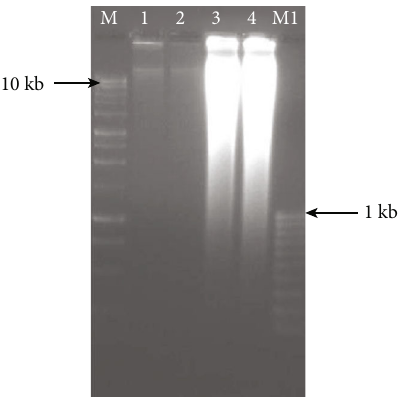
Figure 3: Whole-genome ampli fi cation (WGA) of 4 female reniform nematodes using REPLI-g Mini and Midi kits. M: 1 kb marker; M1: 00bp marker; 1: 2.5 μ l (26 ng/ μ l) of DNA using the Mini kit; 2: 5.0 μ l (26 ng/ μ l) of DNA using the Mini kit; 3: 2.5 μ l (560ng/ μ l) of DNA using the Midi kit; 4: 5.0 μ l (775ng/ μ l) of DNA using the Midi kit).